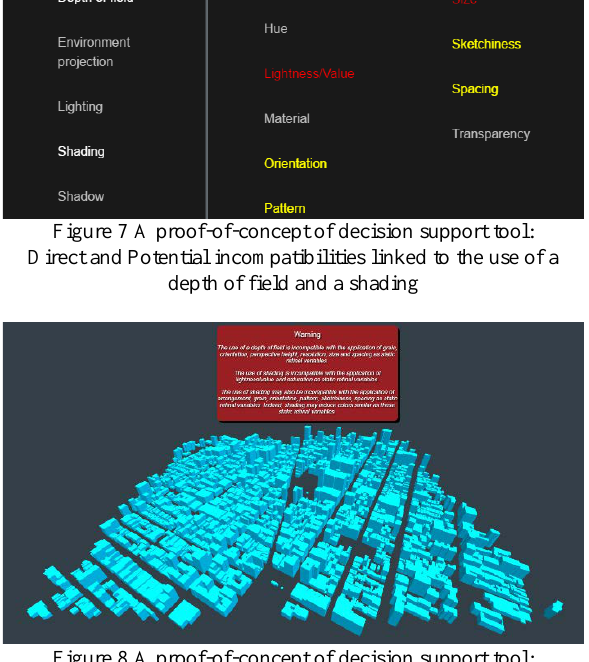
Figure 8 A proof-of-concept of decision support tool: A warning window linked to the use of a depth of field and a